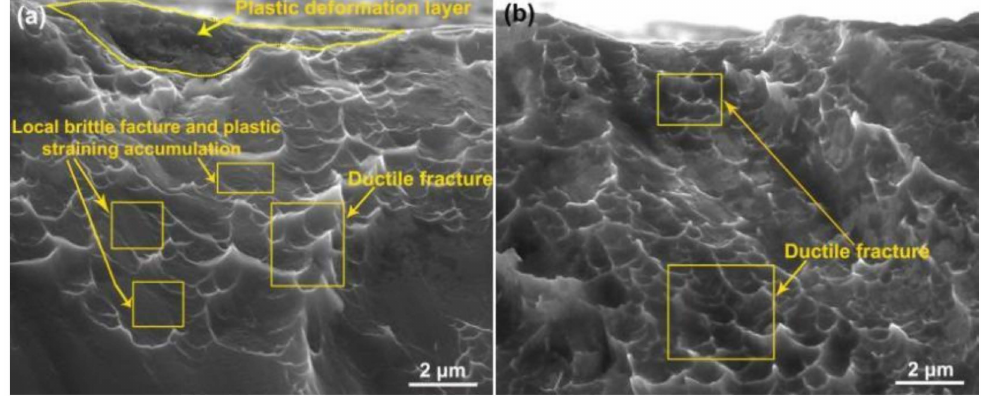
Figure 10. Cross-sectional SEM images of the wear tracks: ( a ) material M1, ( b ) material